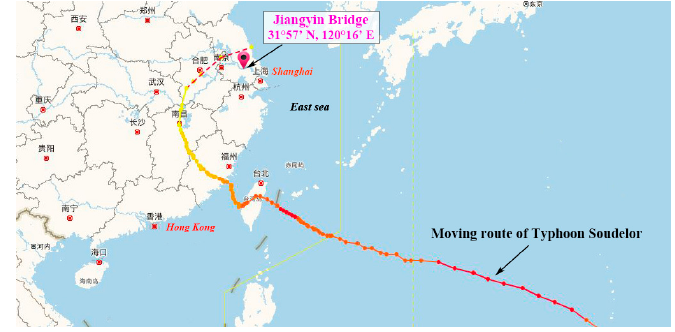
Figure 2. Moving route of Typhoon Soudelor.